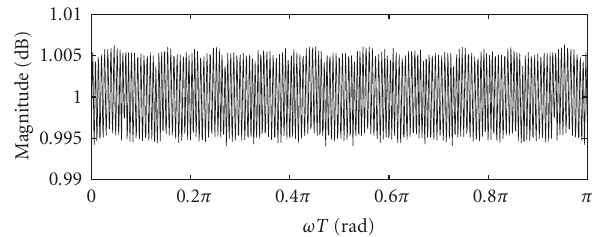
Figure 11: Magnitude response of the distortion function without the nonlinear optimization procedure with N G = 39 and N F = 58, Example 1.